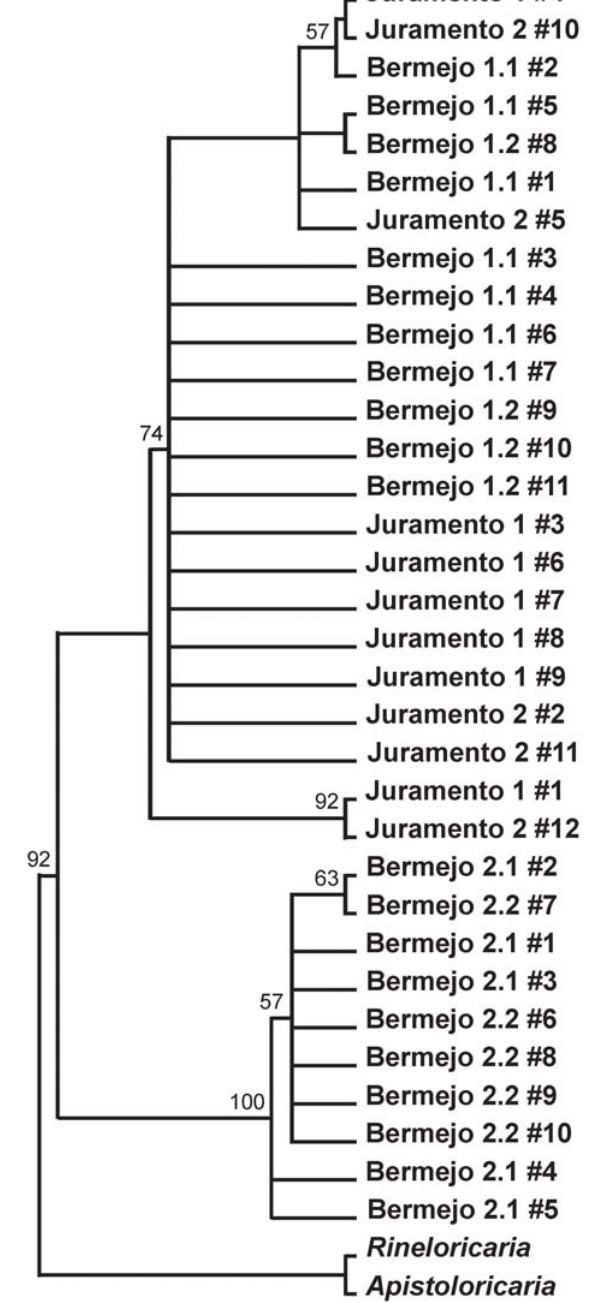
Fig. 3. Best tree from maximum likelihood analysis. –ln L=1643.94356. Numbers above branches are values from 1000 bootstrap replications.